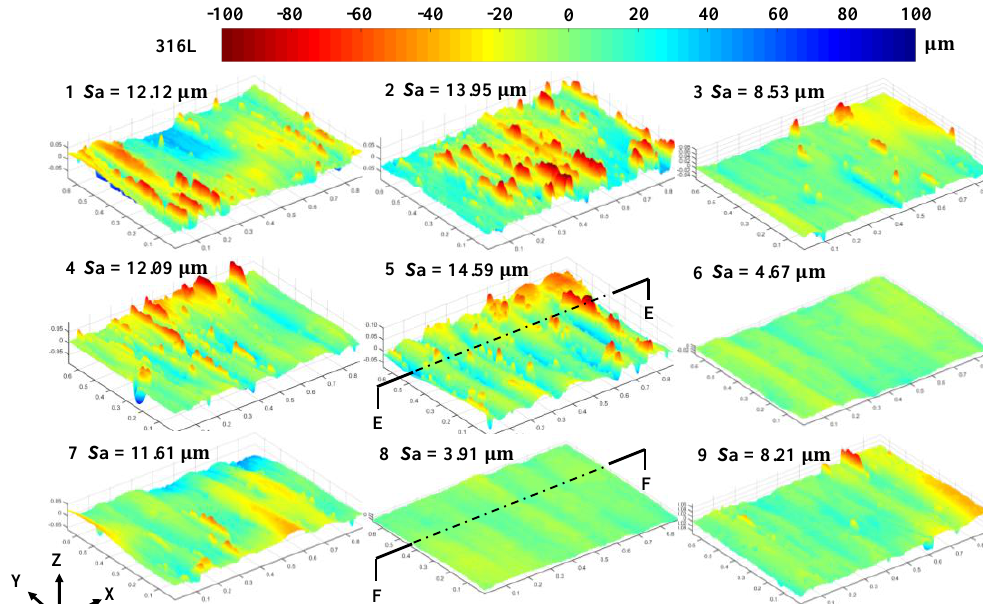
Appl. Sci. 2020 , 10 , 760 Figure 5. Three-dimensional contours of the AlSi10Mg sample after laser polishing.